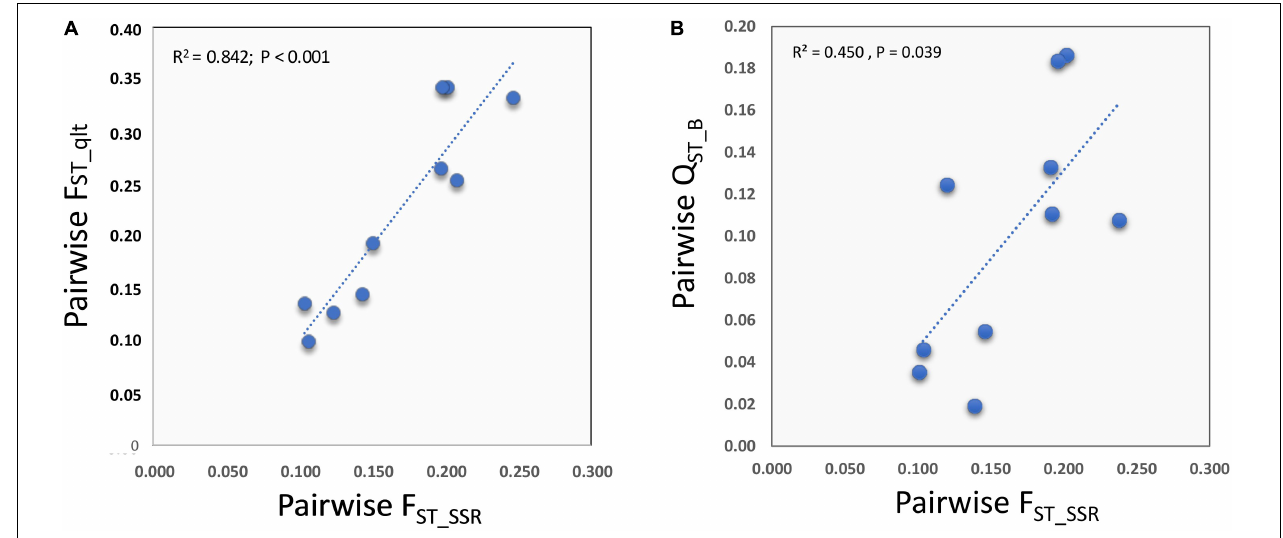
FIGURE 7 | Relationships between the degree of phenotypic divergence for qualitative (A) and quantitative (B) traits for the phenotypic traits listed in Supplementary Table 3 and the pairwise genetic distances between groups for the SSR markers.